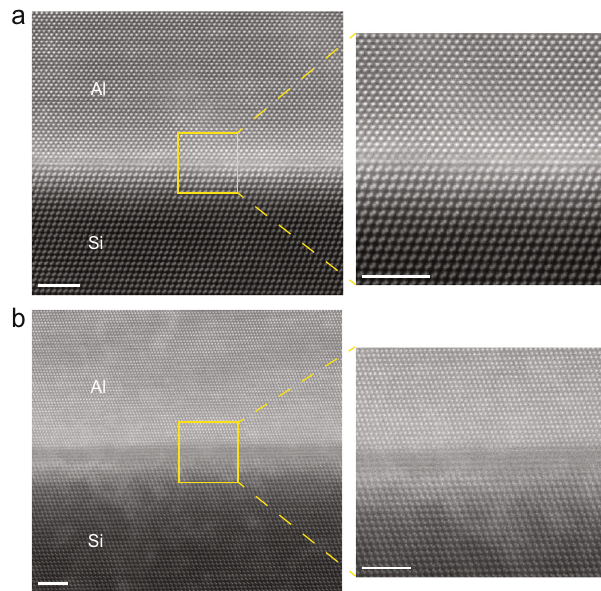
Fig. 2 | Interface structure of Al/Si Sample 1 and Sample 2. Cross-sectional TEM image of Al(111)/Si(111) Sample 1 ( a ) and Sample 2 ( b ). Scale bars are